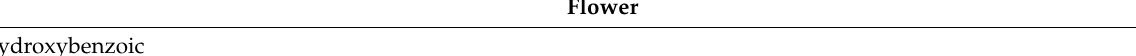
Table 4. Major hydroxybenzoic acid derivatives detected in some edible flowers.